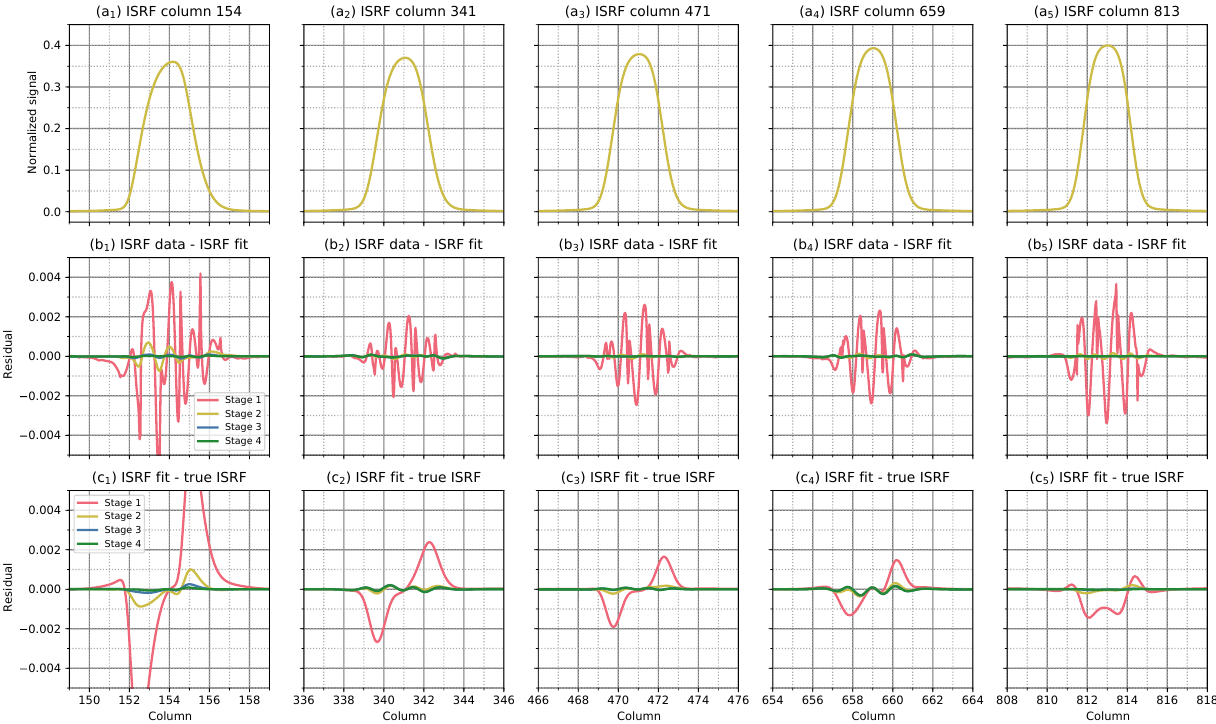
Figure 6. Convergence of five synthetic ISRF determinations in four stages. The upper panels (a) show the shapes of synthetic ISRF closely resemble the ISRF examples as shown in Figs. 3–5. The middle panels (b) show the difference between the ISRF data points and the ISRF fit. The lower panels (c) show the difference between the ISRF data points and the true